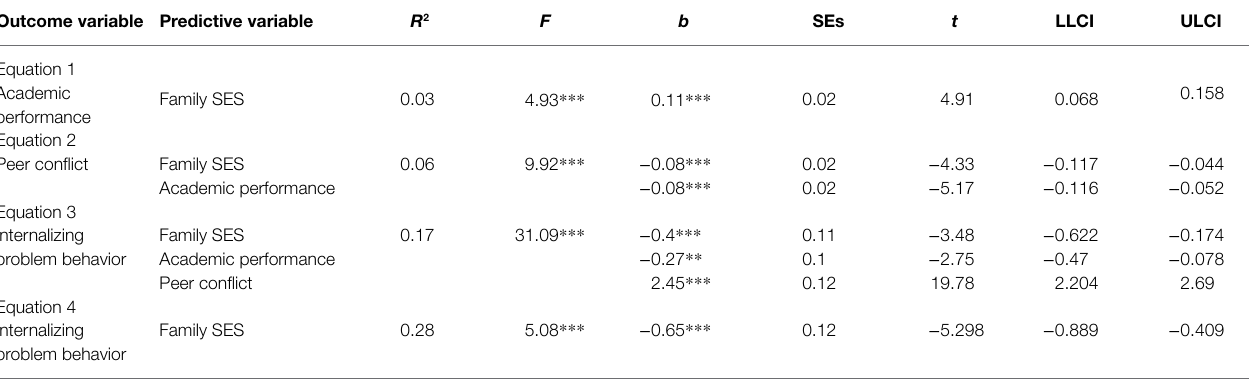
TABLE 3 | Regression results of the chain mediating effects model ( n =